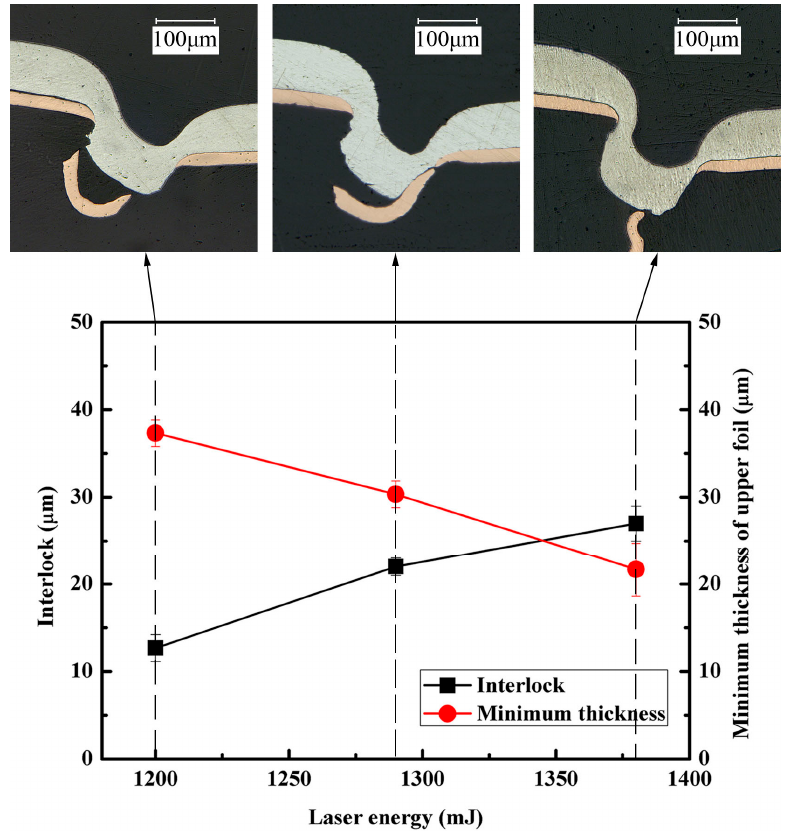
Figure 13. Effect of laser energy on the interlock and minimum thickness of upper foils.